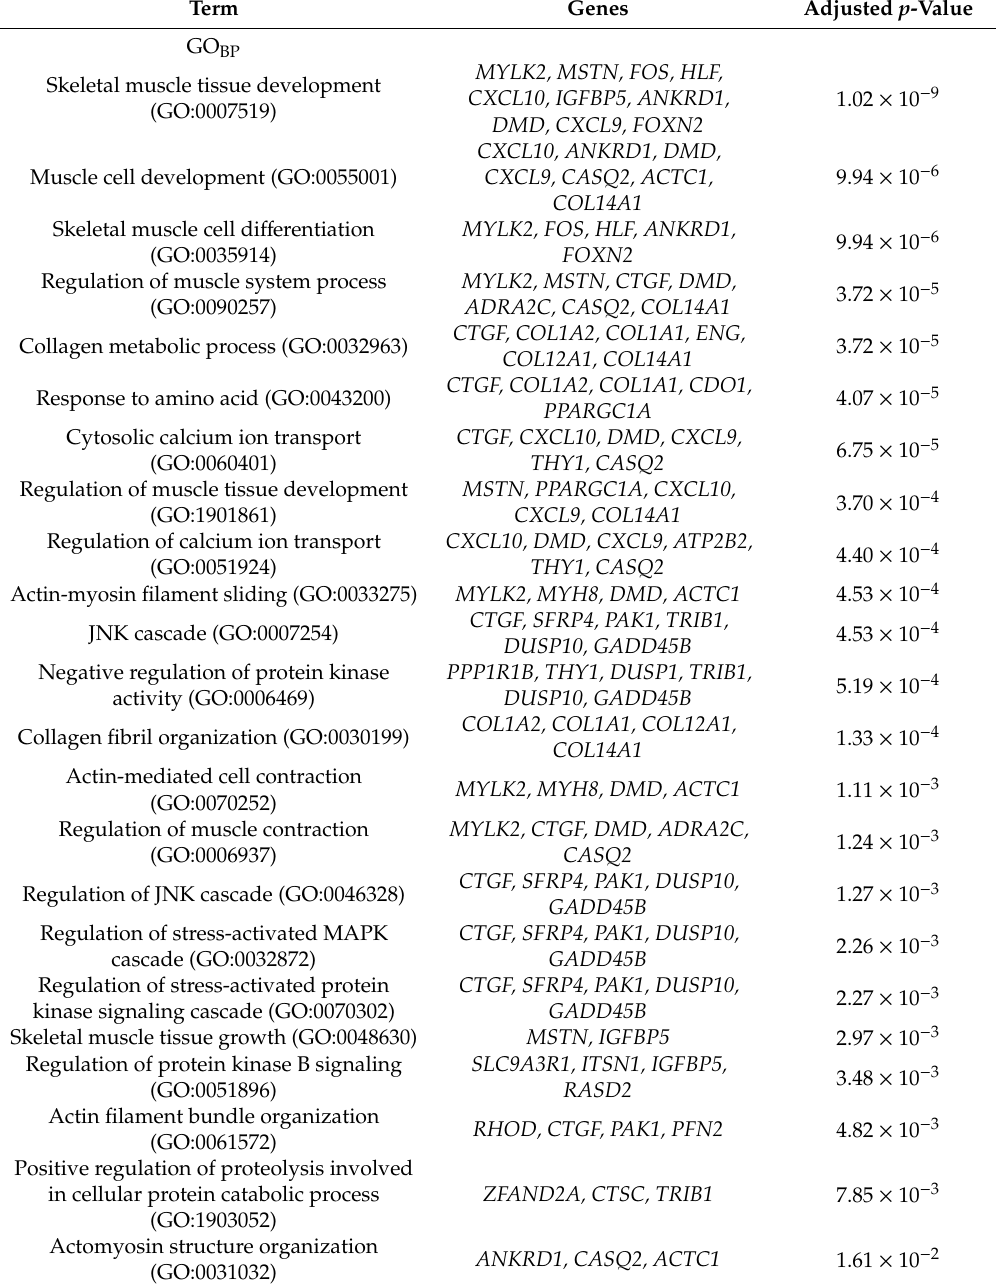
Table 2. Summary of the most relevant significantly overrepresented Gene Ontology (GO) terms related with tenderness on di ff erentially expressed genes (DEGs) using